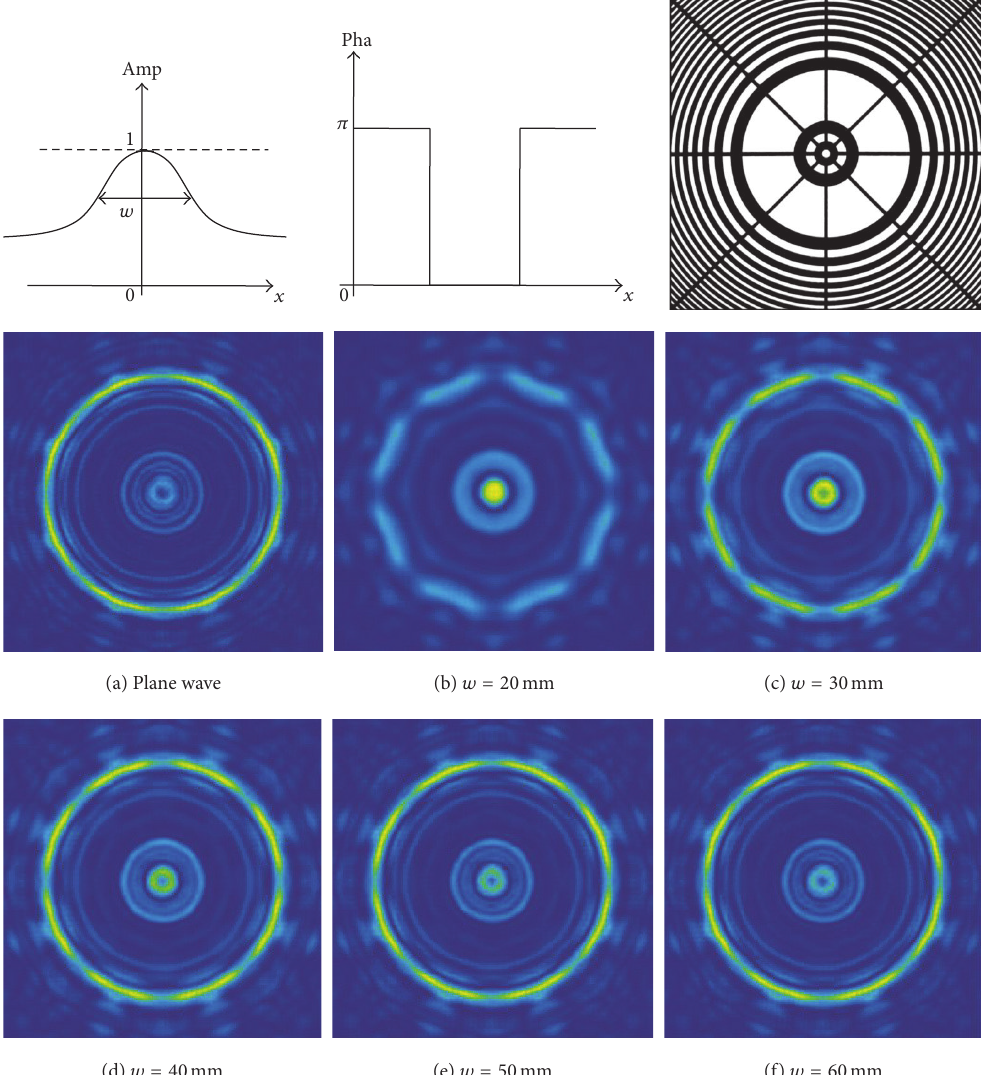
Figure 10: Thesimulation parameters(amplitude and phase diagrams togetherwith thestructure’sphase distribution). Intensity distributions (simulation results) for different lens illumination. Diffractive structures were illuminated with Gaussian beams with different waist values 𝑤 (in mm) as follows: 20, 30, 40, 50, and 60, shown in (b)–(f), respectively. In case of sufficient illumination (plane wave) (a).